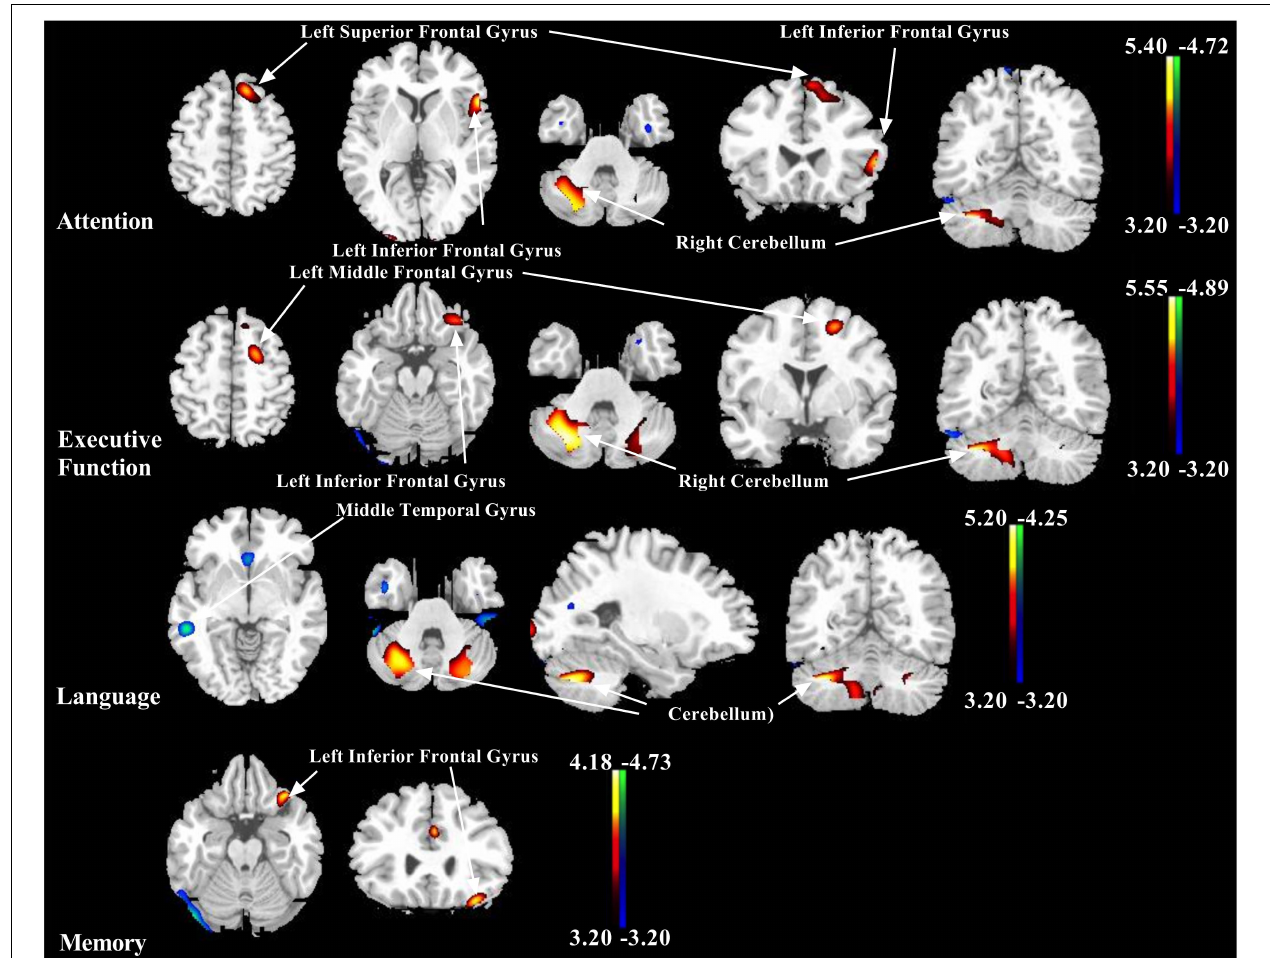
FIGURE 1 | Representative images showing correlations between Z -score of each cognitive domain and 18 F-fluorodeoxyglucose ( 18 F-FDG) metabolism in patients with multiple system atrophy (MSA). Positive relationships are displayed with a red-yellow scale while negative relationships are displayed using a blue-green scale. Both are overlaid on a structural magnetic resonance image (MRI) brain template. White arrows show the representative brain regions. The thresholds of the color bars indicate T -values, and voxel threshold was set at p <